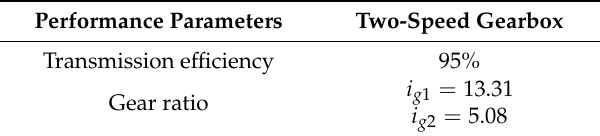
Table 3. Performance parameters of the two-speed